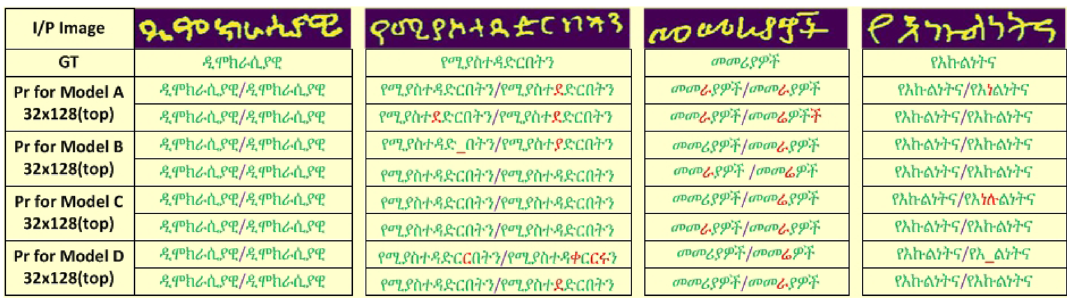
image size of 32 × 128 while bottom row is for 64 × 256 input word image size. The prediction results are represented as with/ without augmentation separated by slash symbol on each